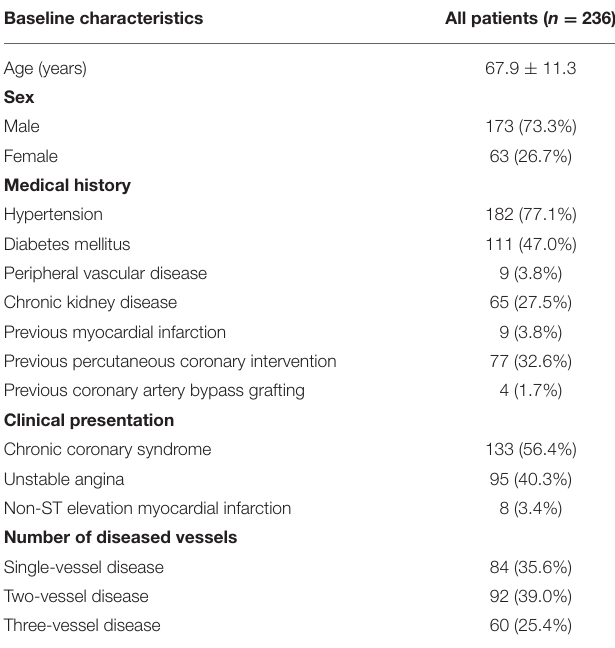
TABLE 1 | Baseline characteristics of